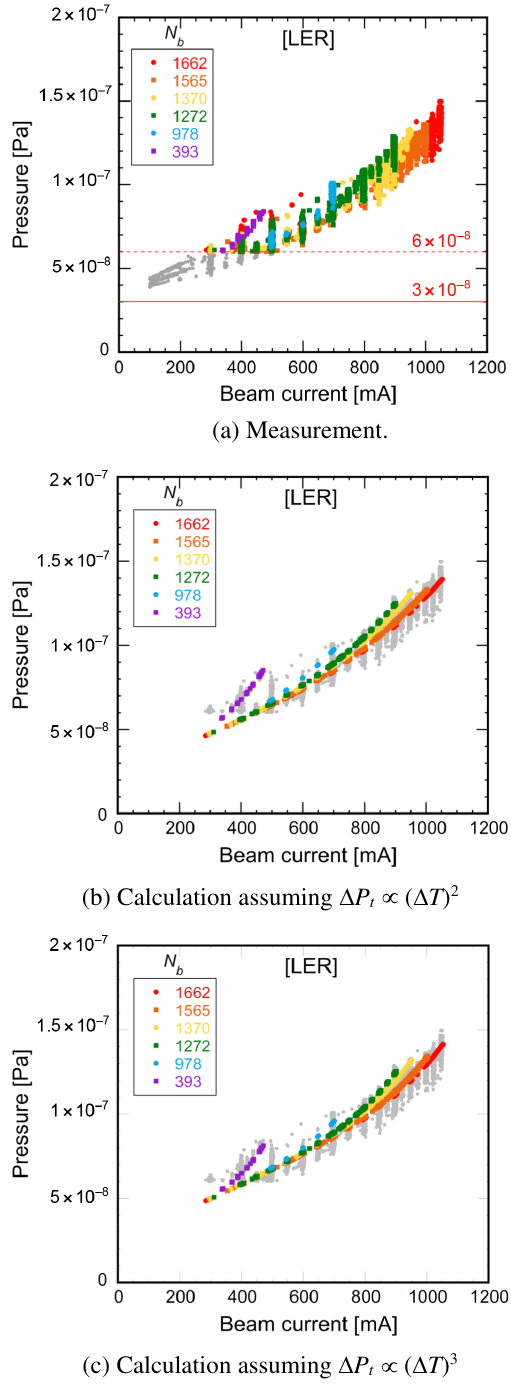
FIG. 8. Dependences of P on I (a) measured, (b) calculated using the regression curve derived assuming Δ P t ∝ ð Δ T Þ 2 , and (c) those derived assuming Δ P t ∝ ð Δ T Þ 3 for several N b of 393 – 1662 for LER, where the P values higher than 6 × 10 − 8 Pa from the 16th of March to 25th of April 2022 were used for the MRA. Gray points represent all